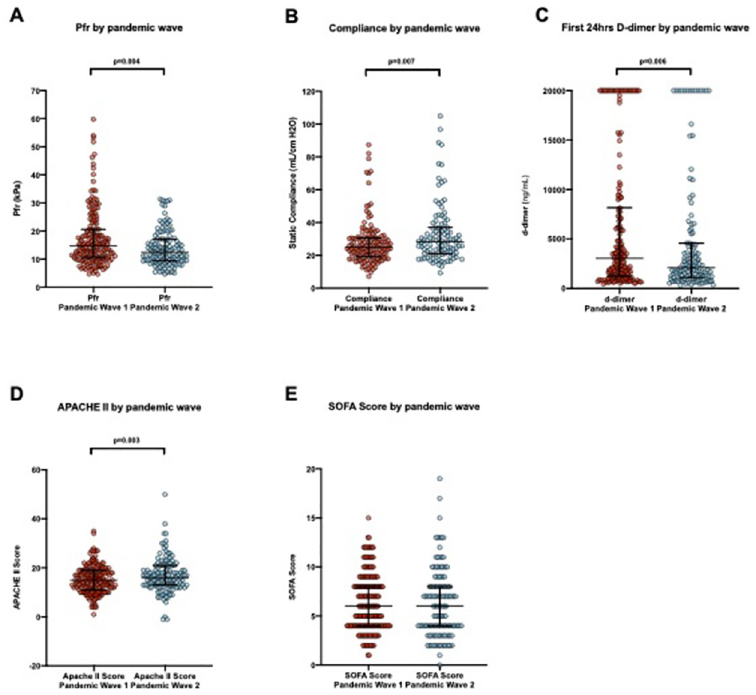
Fig 2. Ventilator, biochemical and physiological data. A-E) demonstrates the change in static compliance, Pfr, plasma d-dimer, APACHE II and SOFA score respectively. Upper limit for d-dimer concentration is 20,000ng/mL.